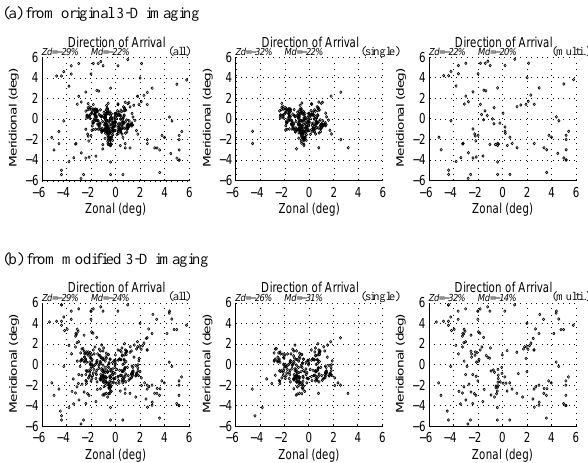
Figure 8. Similar to Figure 6, but resulting from the 2-D radar imaging of multi-receiver echoes.